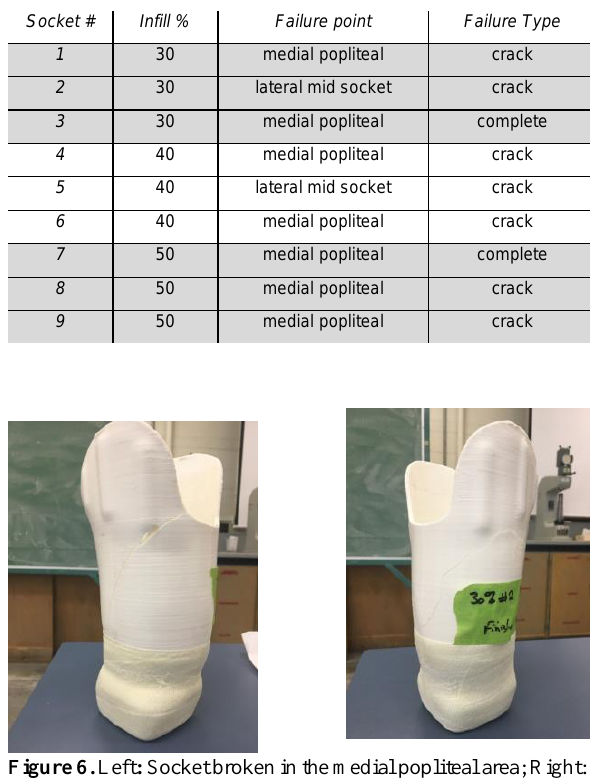
Table 3. Area of Socket Failure and Failure Type